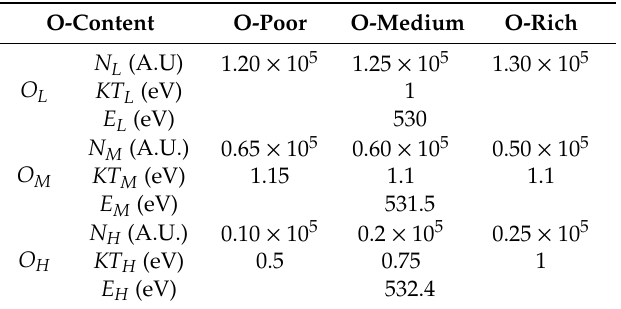
Figure 1. X-ray photoelectron spectroscopy (XPS) O 1 s spectra of InGaZnO (IGZO) films upon varying the flow rate in a mixed atmosphere of Ar and O 2 (oxygen flow rate (OFR) = 35 sccm). The OFR is modulated to produce O-poor (OFR = 21 sccm), O-mid (42 sccm), and O-rich (63 sccm) IGZO thin films. The inset shows the surface morphology of IGZO thin films as a function of OFR, as observed by atomic force microscopy (AFM). Table 1. Extracted XPS parameters (initial).